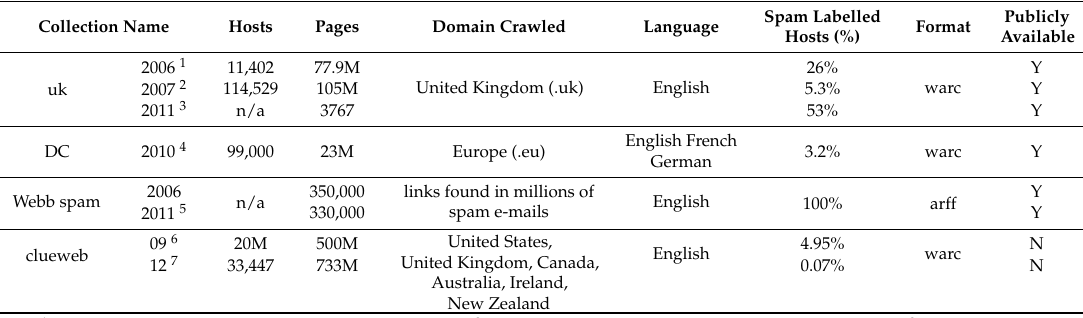
Table 1. Available corpora for web spam